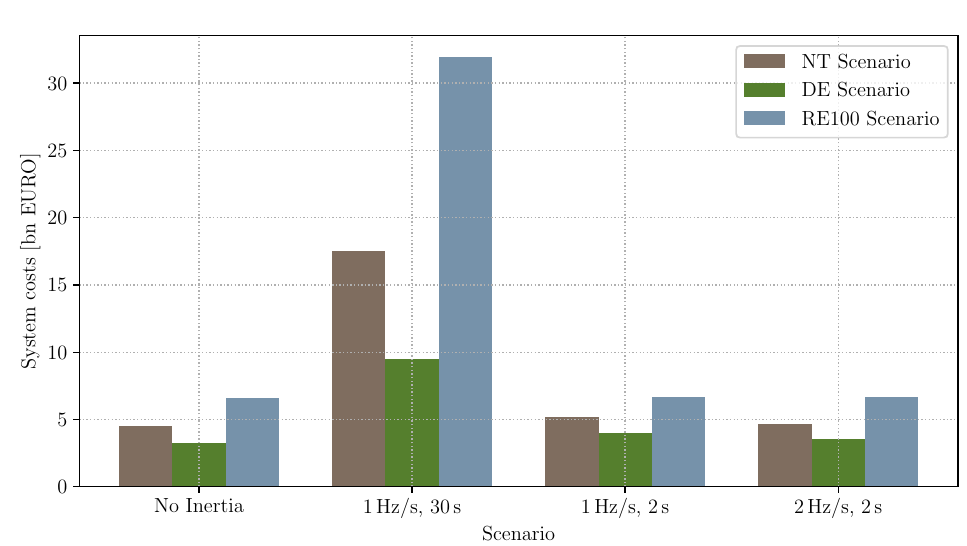
Figure 7. Illustration of the overall system costs in bn EURO of the analysed scenarios and parame- ter